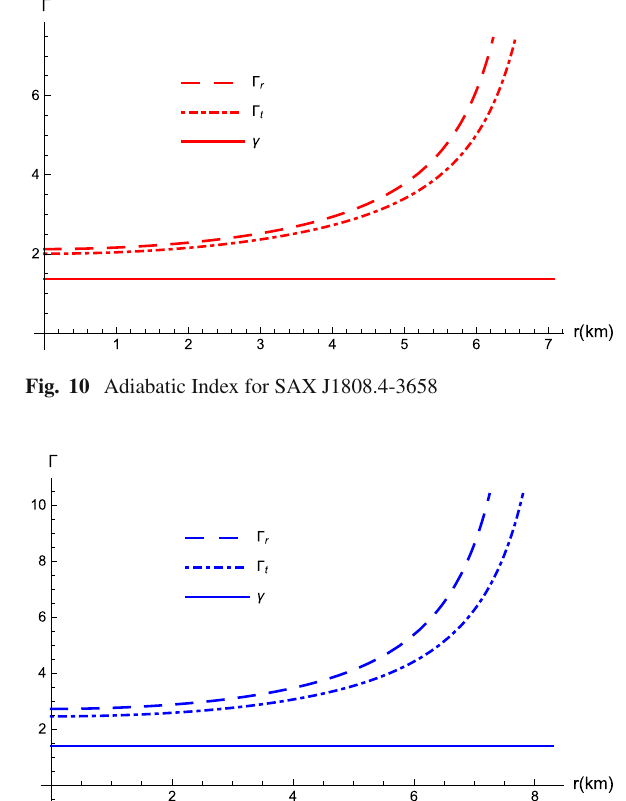
Fig. 8 Adiabatic Index for RXJ 1856-37